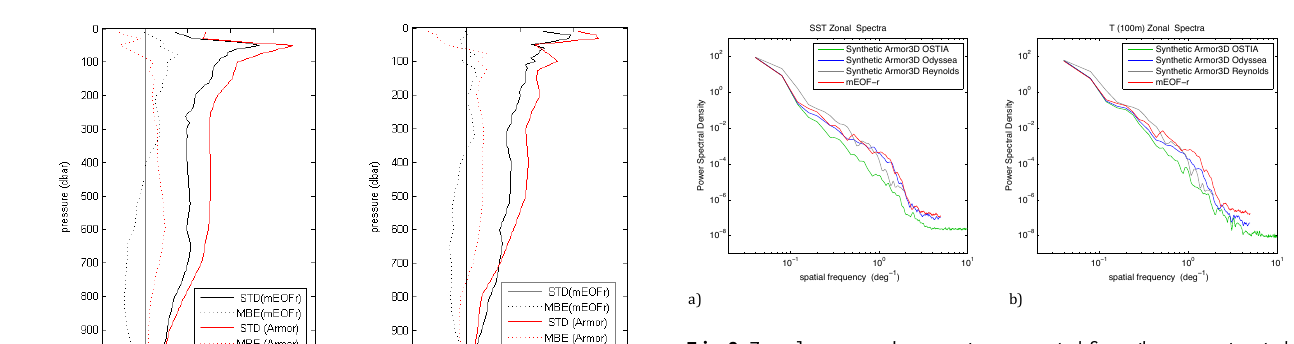
Fig. 8. Zonal wavenumber spectra computed from the reconstructed temperature fields at the surface (a) and at 100m depth (b) .